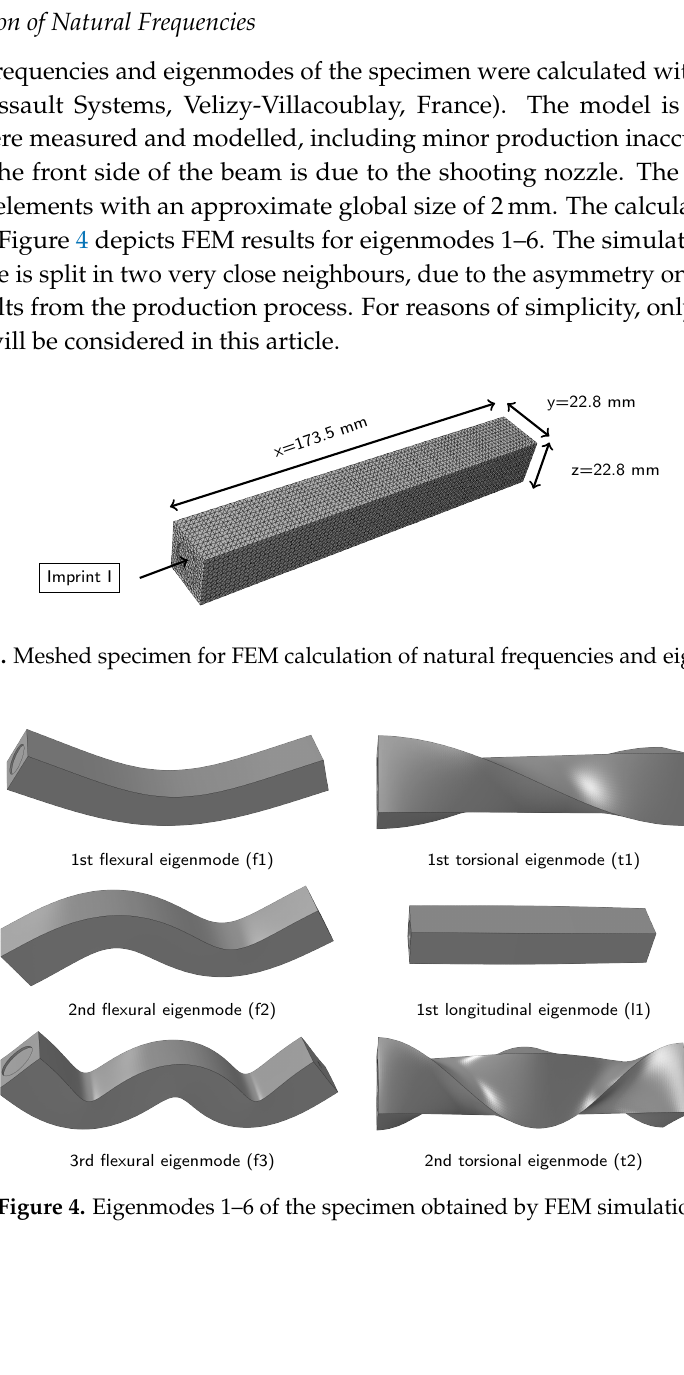
Figure 2. Algorithm for determining elastic parameters via impulse excitation technique and FEM simulation. The measured and calculated eigenfrequencies are compared and the Young’s modulus and Poisson ratio are optimised such, that the error between the measured and the calculated eigenfrequencies is minimal.